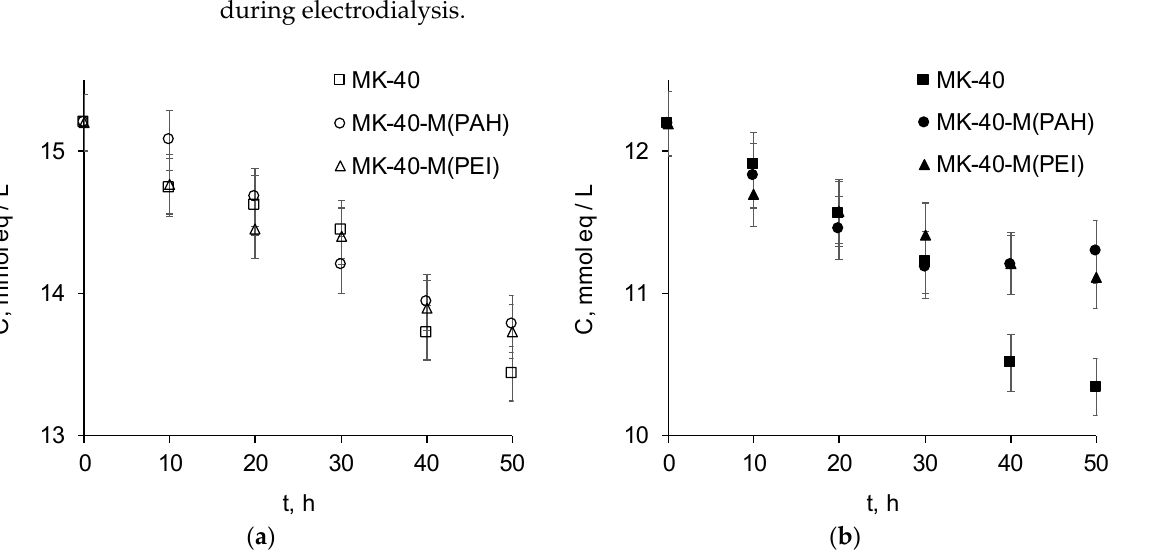
Figure 6. Concentrations of Na + ( a ) and ½ Ca 2+ ( b ) in the desalination tract during electrodialysis. Uncertainty margins reflect the uncertainties of chromatographic determination of concentrations.